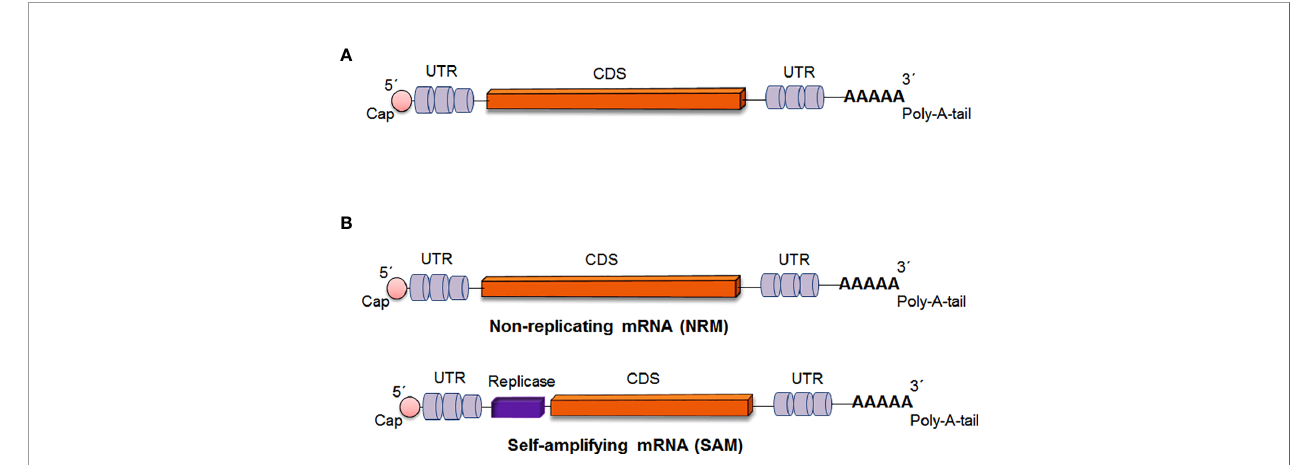
FIGURE 3 | Critical parts of mRNA vaccine construct (A) Critical parts of mRNA vaccine constructs in general (B) Critical parts of two speci fi c types of mRNA vaccine constructs [Non-replicating mRNA (NRM) vaccine and Self-amplifying mRNA (SAM) vaccine].